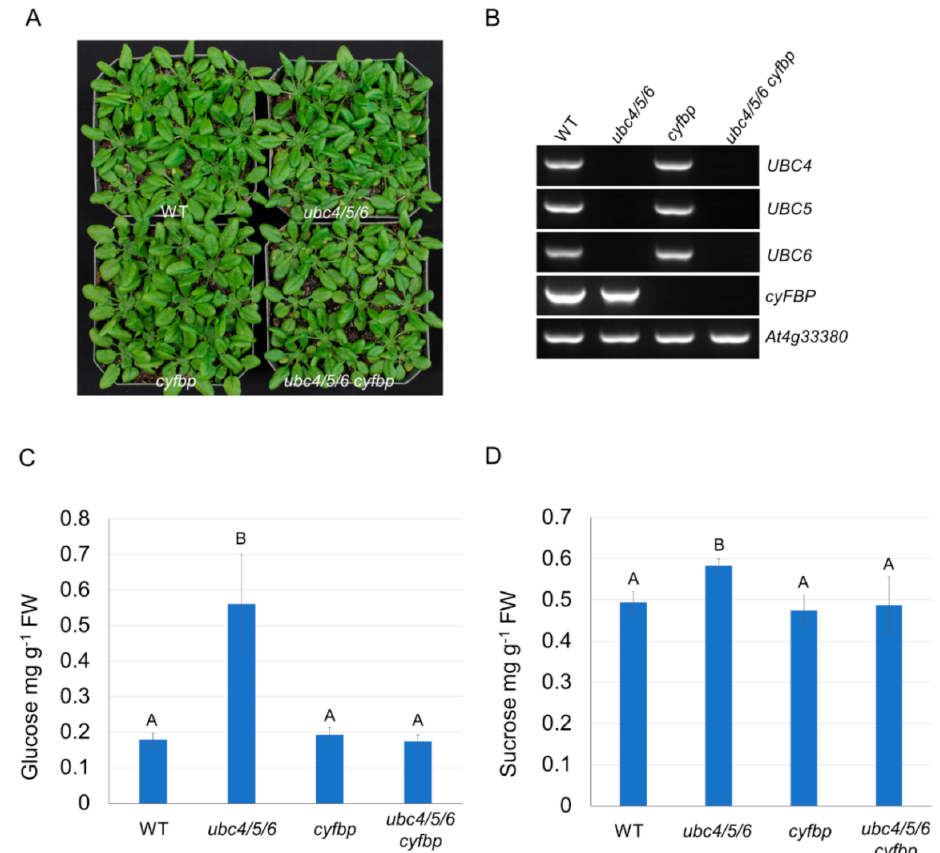
Figure 5. Plant growth and sugar analysis in the WT, ubc4/5/6 , cyfbp , and ubc4/5/6 cyfbp mutant plants. ( A ) WT, ubc4/5/6 , cyfbp , and ubc4/5/6 cyfbp mutant plants grown in pots and the picture was taken at the 5-week stage. ( B ) Genotyping of the ubc4/5/6 , cyfbp , and ubc4/5/6 cyfbp mutant lines by genomic PCR with the WT as the control. The plants lines are indicated above the panels and specific genes analyzed are indicated at the right of the panels. The gene At4g33380 was used as a control. ( C ) Quantitative analysis of the glucose level in the WT, ubc4/5/6 , cyfbp , and ubc4/5/6 cyfbp mutant plants. About 300 mg of leaf tissues from 30-days-old plants were used for the analysis. Each datum (in mg of glucose per gram of fresh tissues) represents the average of four biological replicates (error bar = standard deviation). Data were analyzed using one-way ANOVA and post-hoc Tukey test, and significant differences are indicated by different letters (upper case) at p < 0.01 level. ( D ) Quantification of the sucrose level in the WT, ubc4/5/6 , cyfbp , and ubc4/5/6 cyfbp mutant plants. About 300 mg of leaf tissues from 30-day-old plants were used for the analysis. Each datum (in mg of sucrose per gram of fresh tissues) represents the average of four biological replicates. The error bars indicate standard deviations. Data were analyzed using one-way ANOVA and post-hoc Tukey test, and significant differences are indicated by different letters (upper case) at p < 0.05